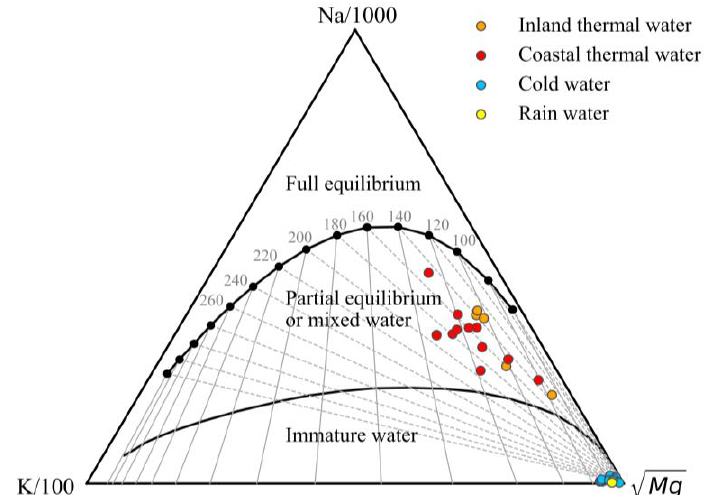
Figure 5. Na-K-Mg diagrams for various water in southeastern China.